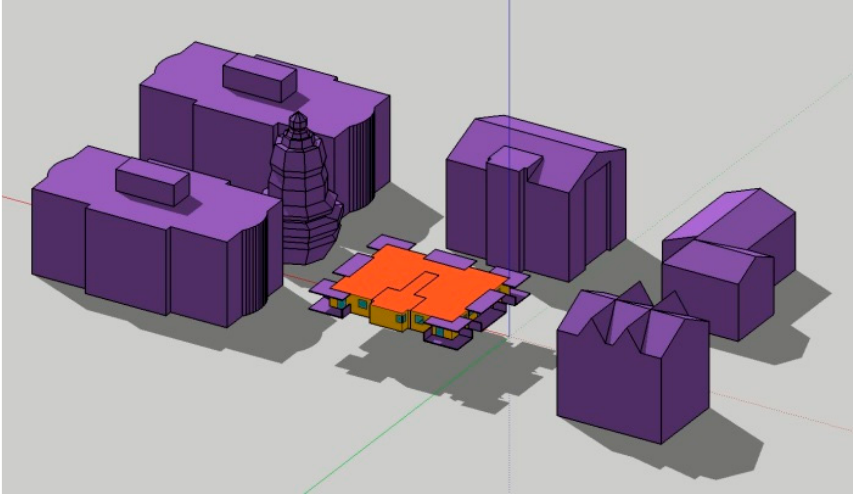
Figure 2. Case study geometrical model (objects modelled as shadings and obstructions are colored in purple).